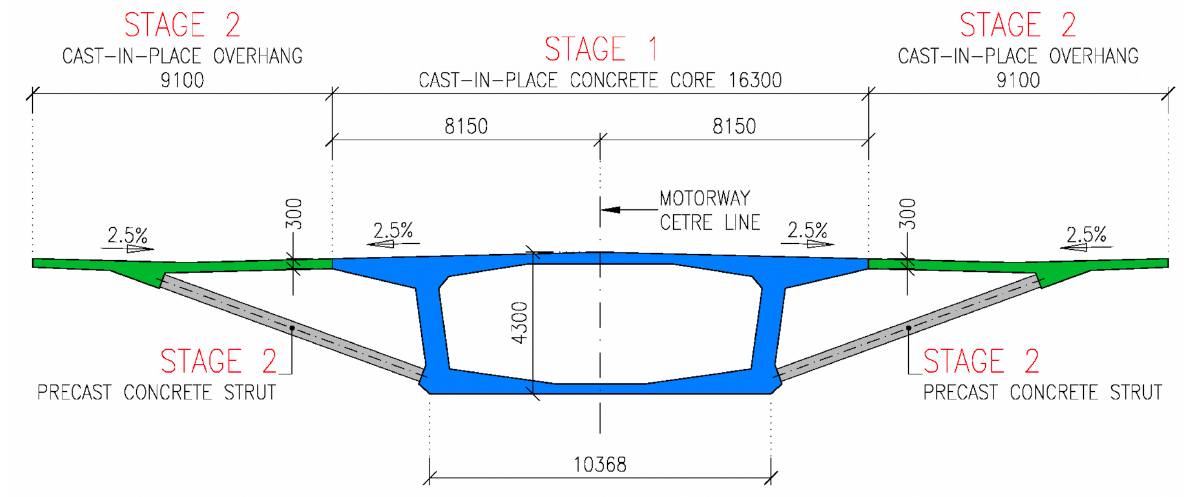
Figure 4. Deck cross-section construction